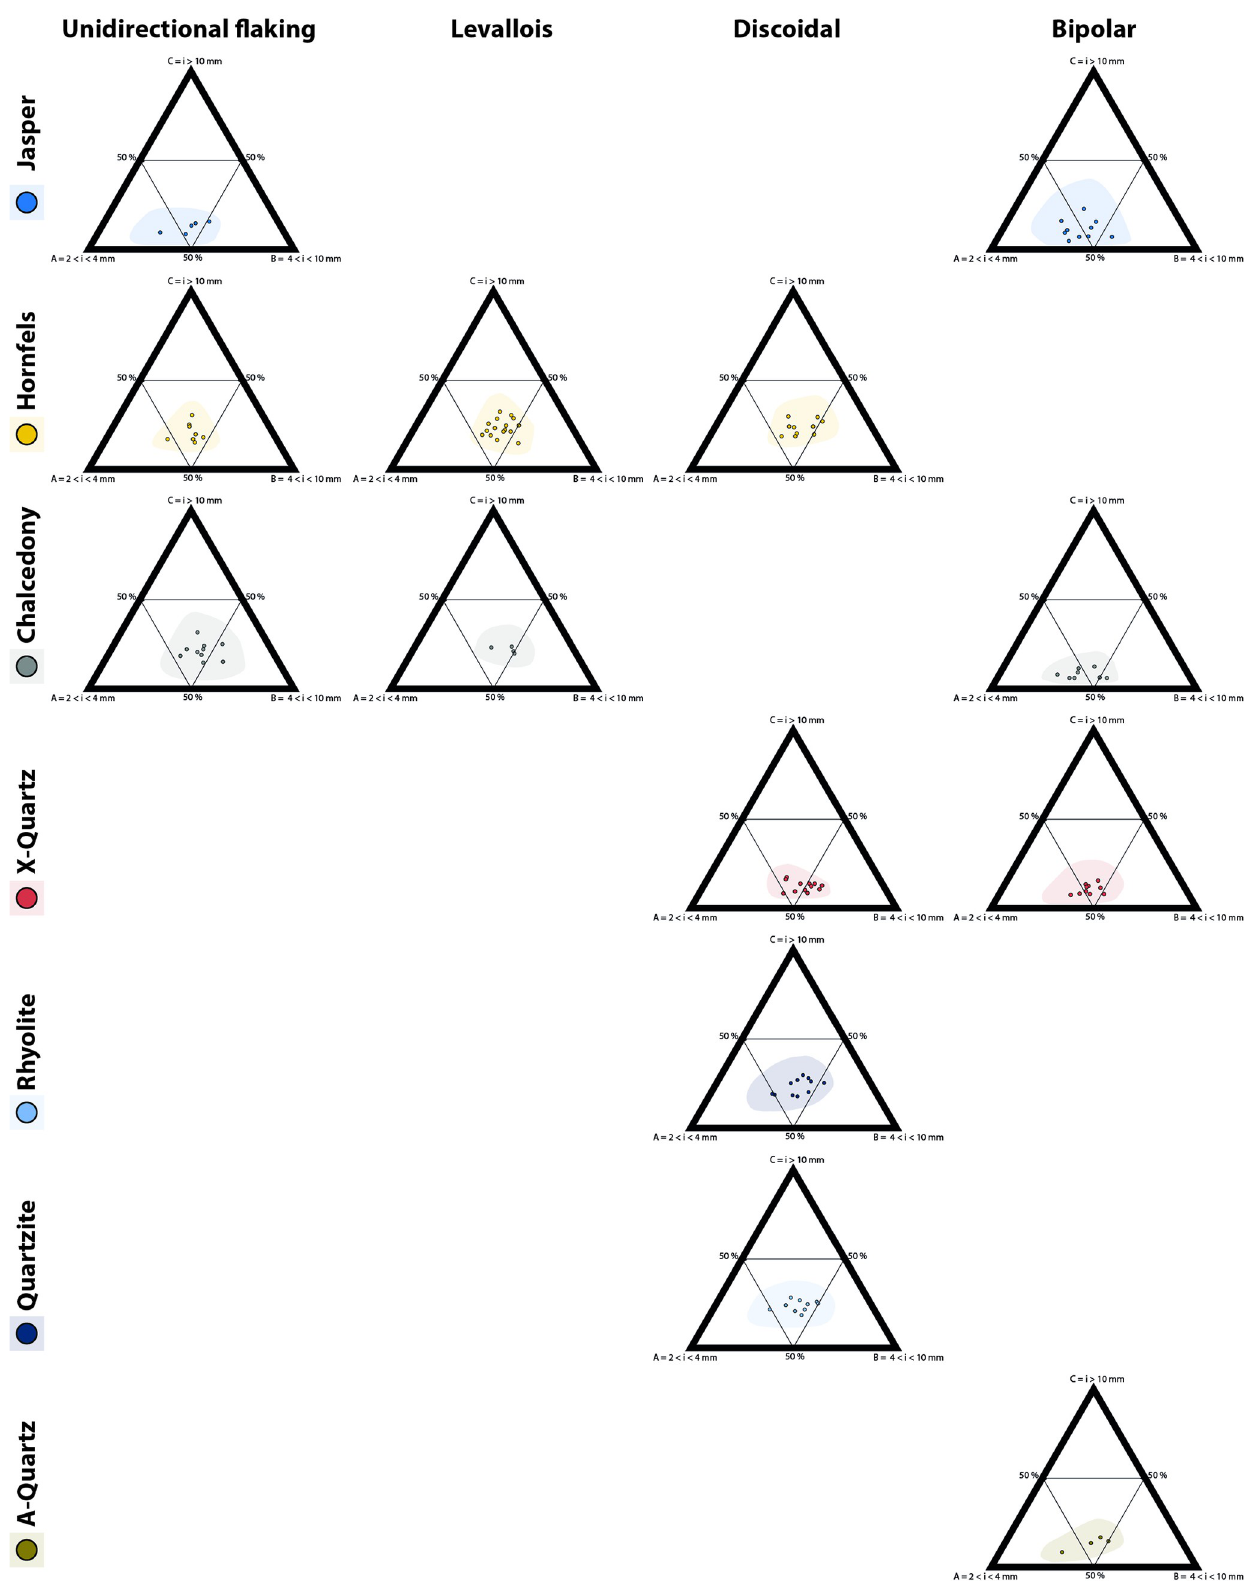
Fig 7. Ternary plots per raw material and knapping method in the SA dataset (counts). Shaded areas are 95% confidence intervals. https://doi.org/10.1371/journal.pone.0278867.g007 PLOS ONE | https://doi.org/10.1371/journal.pone.0278867 December30,